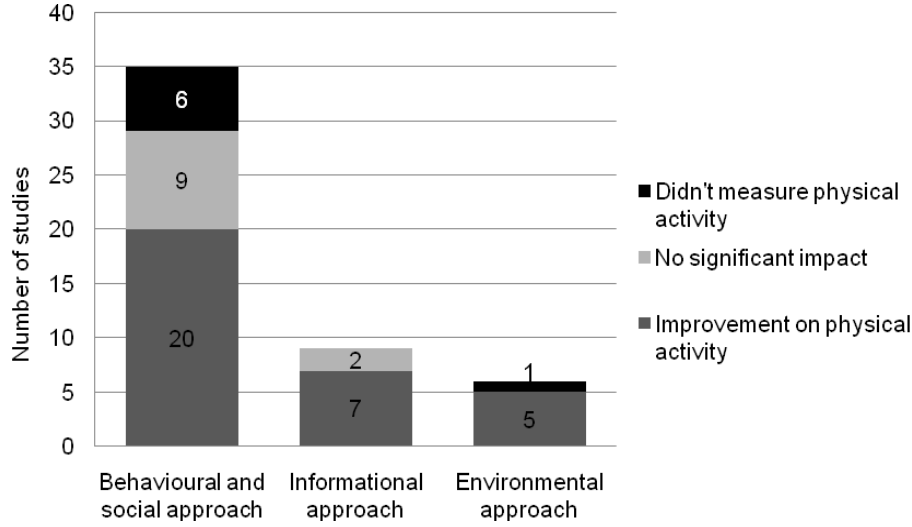
Figure 1. Impact of interventions on physical activity.